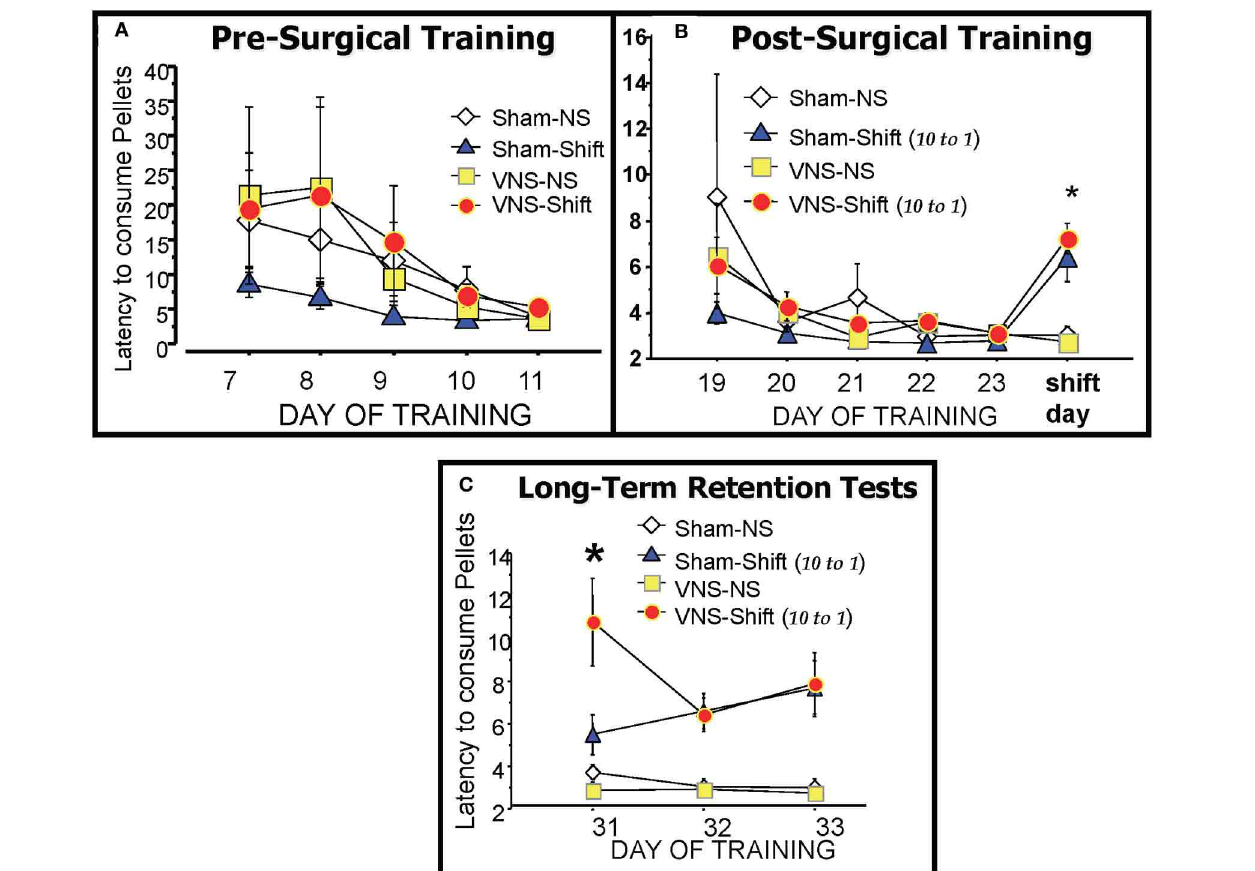
FIGURE 2 | The runway latencies of each training group during pre-surgical training (A), post-surgical training (B) and during the three days of retention testing (C). There were no significant differences between groups during the training periods. The reduction in reward magnitude from 10 pellets to only 1 pellet on the day of the Shift resulted in significantly longer latencies in the two shifted groups (Sham-Shift and VNS-Shift) relative to the Non-Shifted controls (Sham-NS and VNS-NS). The VNS-Shift group received vagal stimulation after the six training trials